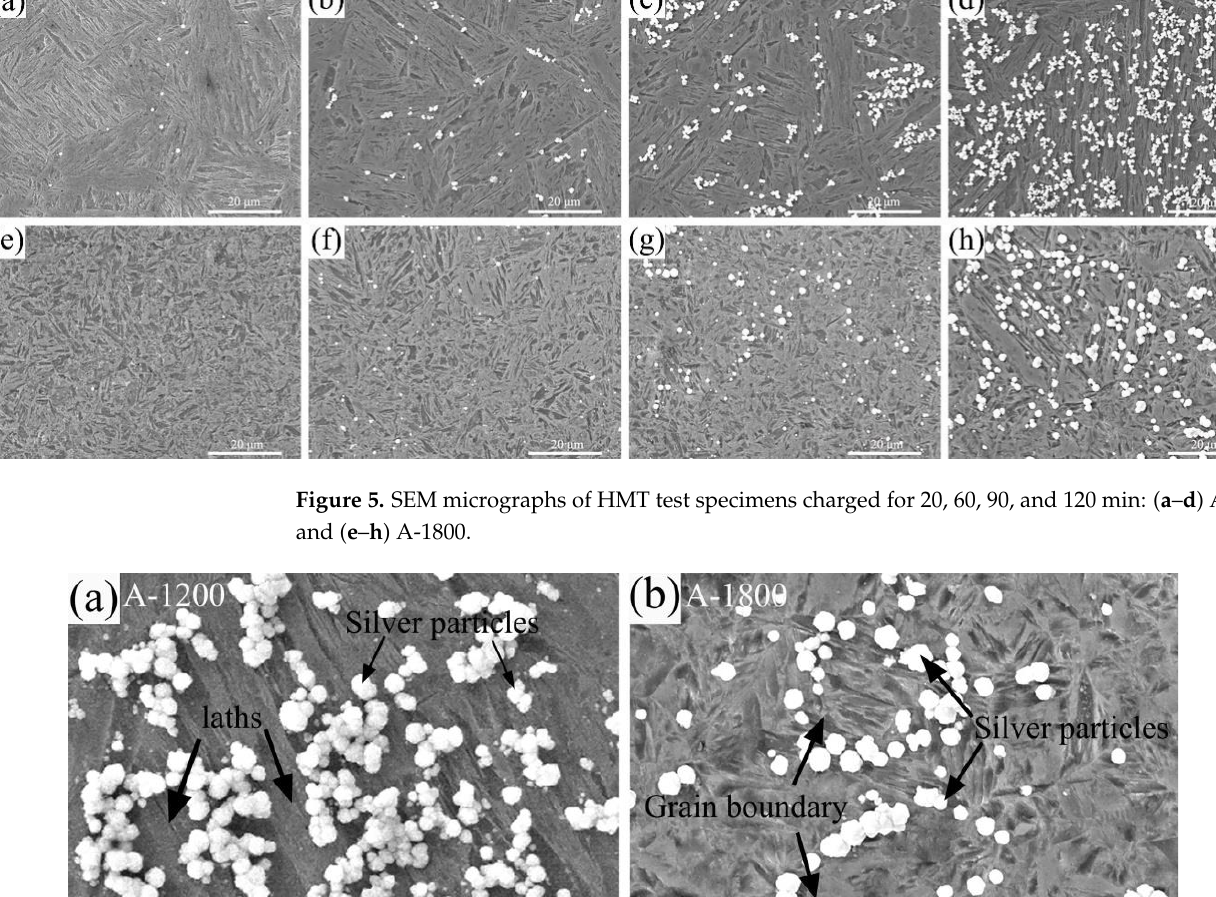
Figure 7. Grain sizes and EBSD maps of ( a , c ) A-1200 steel and ( b , d ) A-1800 steel, as well as their ( e ) misorientation distributions and ( f ) LAGB area fractions.